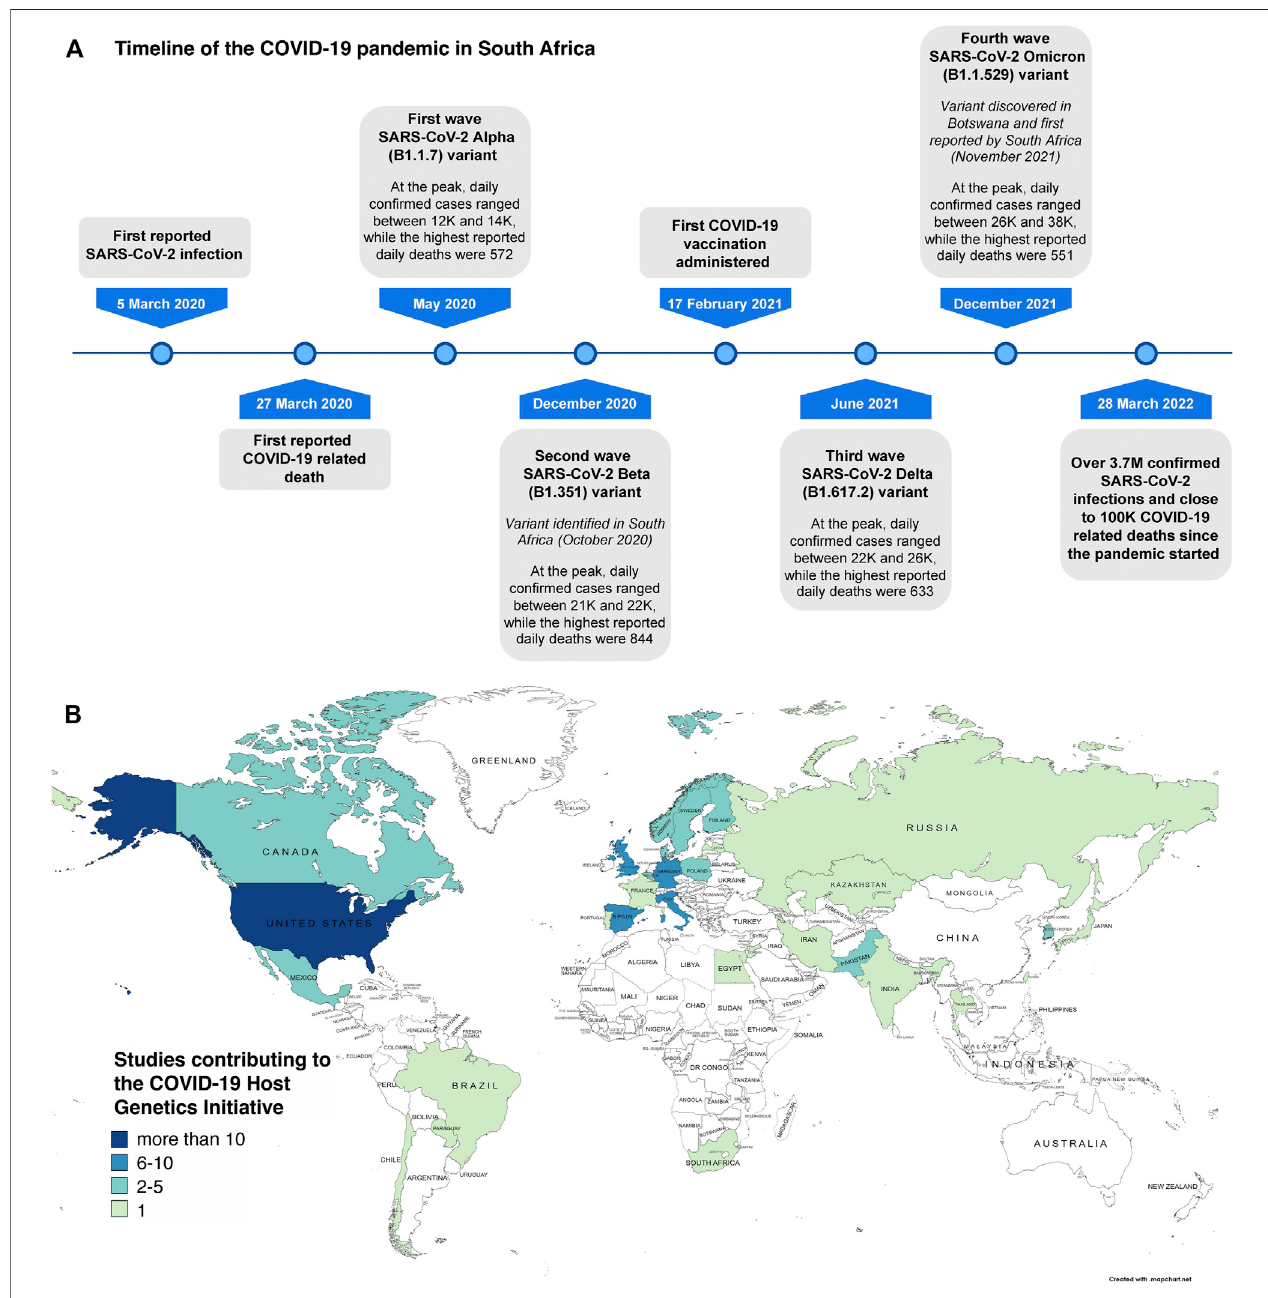
FIGURE1| SARS-CoV-2varianttimepointsinSouthAfricaandlimitedhumangeneticstudiesinAfrica. (A) indicatesthesigni fi canttimepointswhereSARS-CoV-2 variantsemergedandhowthisshapedthedirectionoftheCOVID-19pandemicinSouthAfrica(createdusingdatafromhttps://covid19.who.int/region/afro/country/za). (B) shows the partners of the COVID-19 Host Genetics Initiative (adapted from https://www.covid19hg.org/partners/). Our own research project entitled, “ Host genetic factors contributing to susceptibility to COVID-19 in South Africans ” is a registered study with this international effort.